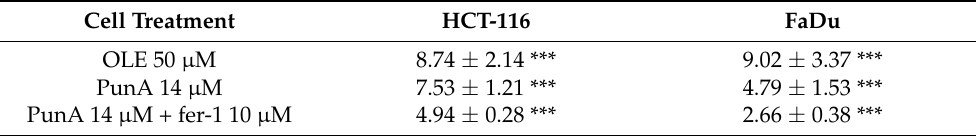
Table 1. Fatty acid relative absorption by carcinoma cells after 18 or 36 h. Ratio of the final to the initial amount (nmol) of the corresponding fatty acid in cell culture medium in contact with HCT-116 or FaDu carcinoma cells for 18 or 36 h, respectively, upon treatment with oleic acid (OLE) 50 µ M, of cell culture medium supplemented with the corresponding treatment. Results are expressed as mean ± standard error of the mean of three independent repetitions. Significance is established in relation to the initial amount of the corresponding fatty acid in cell culture medium (considered as 100%). *** p ≤